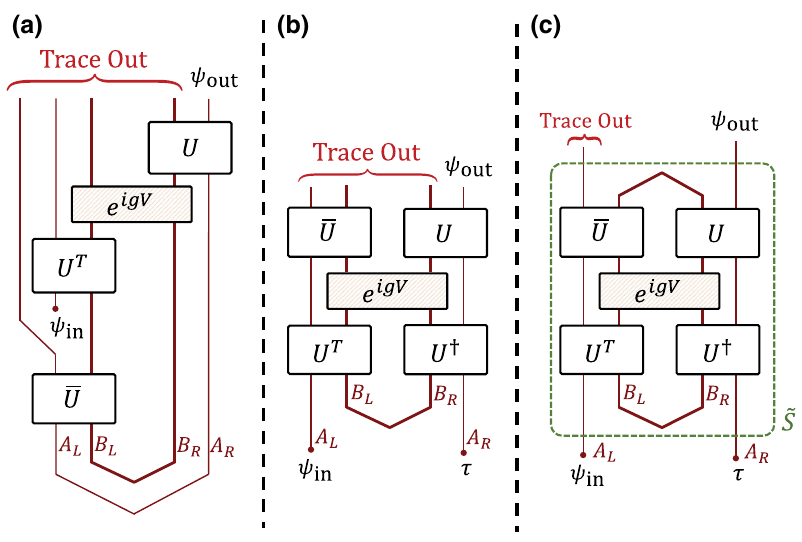
FIG. 3. (a) An Infinite-temperature holo- graphic teleportation circuit, with U = e − iHt . (b) An equivalent circuit to (a) after circuit manipulations. (c) The result of replacing the trace by projecting the carrier qubits onto | φ + (cid:2) . When the teleportation has high fidelity, this projection has a negligible effect on the final state. For many systems of interest, the ˜ operator S enclosed in the dashed rectangle approximately implements the unitary defined in Eq. (2) for some appropriate g (cid:9)